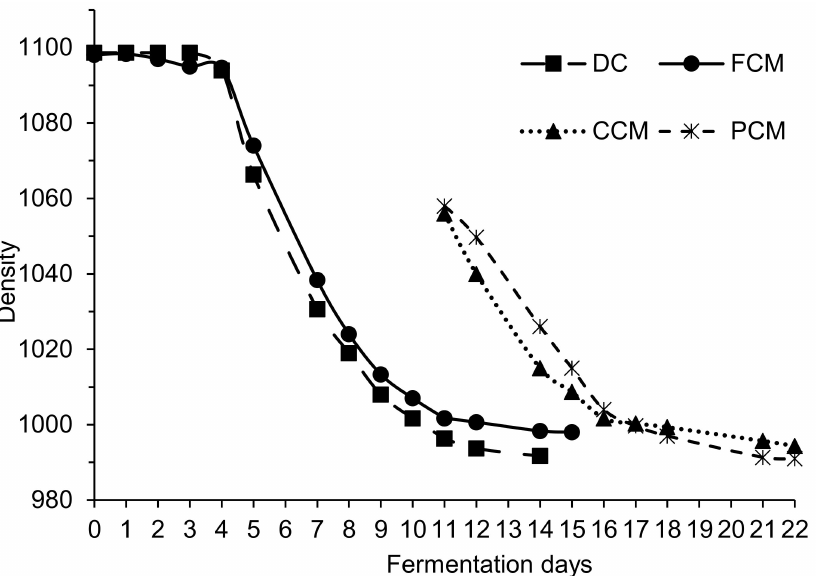
Figure 1. Evolution of the alcoholic fermentation (density) of different types of wines obtained in the experimental winery by destemming and crushing (DC), and in the different fractions obtained in the vinification by carbonic maceration (FCM: free wine, CCM: crushed wine, PCM: press